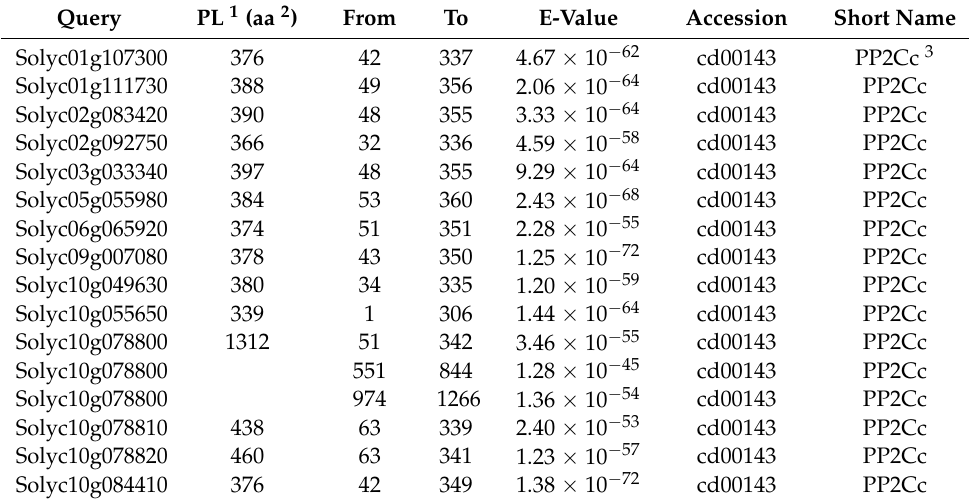
Table 1. Protein length and PP2C domain of SlPP2C.D proteins. Query PL 1 (aa 2